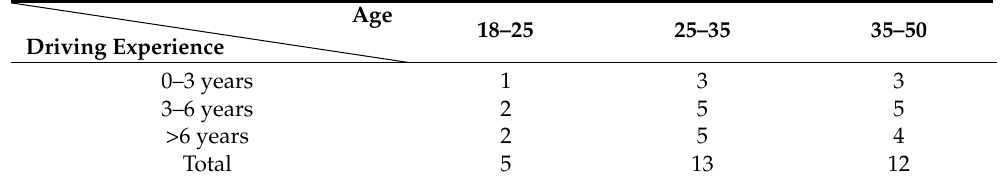
Table 2. Test Sample B.